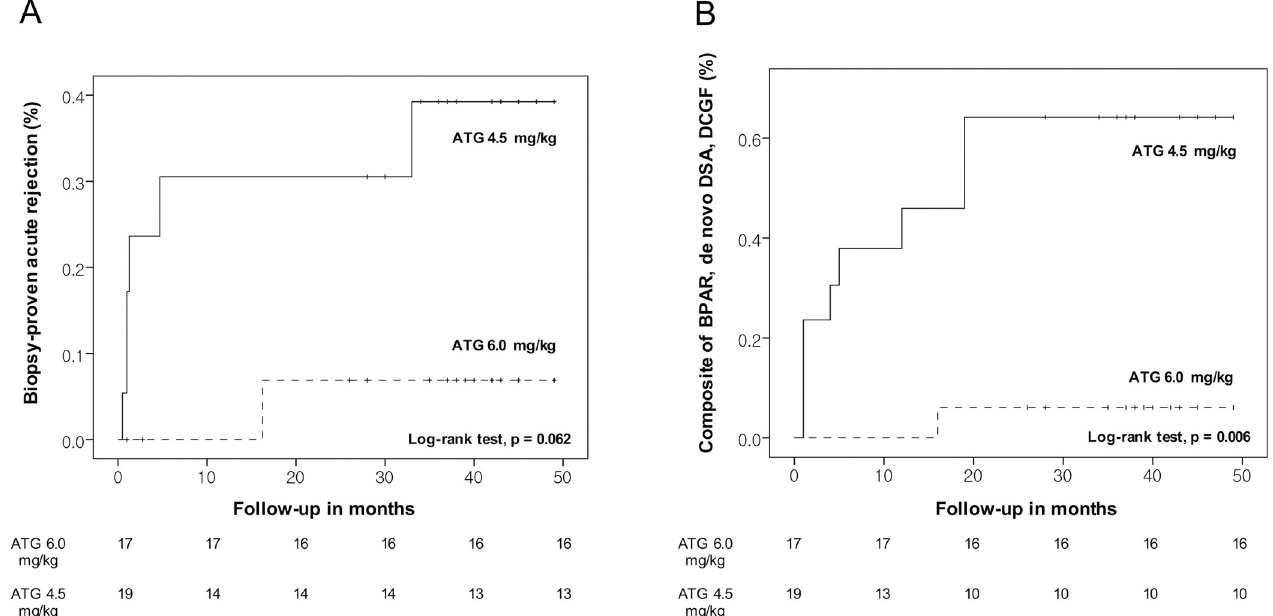
Fig 2. Efficacy end points. Kaplan-Meier curves for BPAR (A) and a composite end point of BPAR, de novo DSA, and DCGF (B) according to the dosage of ATG. BPAR, biopsy-proven acute rejection; DSA, donor-specific antibody; DCGF, death-censored graft failure; ATG, anti-thymocyte globulin.